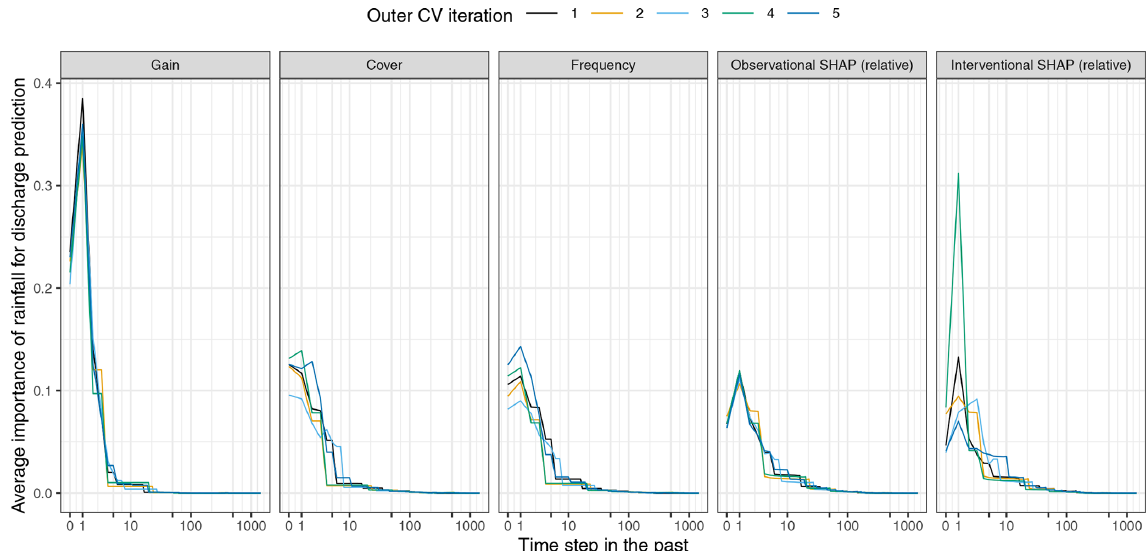
Figure 8. The importance of rainfall from each time step for making discharge predictions assessed by different feature importance measures in the Washington Street SuDS site (WS) XGBoost models. Each line shows the results of model trained during an outer cross-validation (CV) iteration. The x axis is on a pseudo-logarithmic scale. For interventional SHAP, all the training samples are used as background data